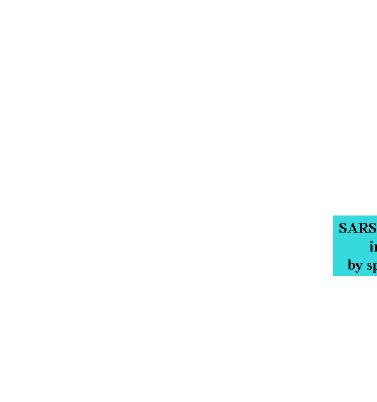
FIGURE 2 Attachment of SARS-CoV-2 with ACE2 binding site of the